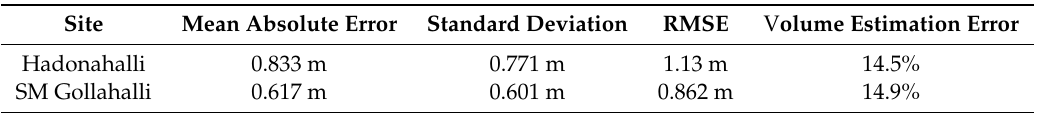
Table 3. Summary statistics for the elevation error measurements and the volume estimation error for Hadonahalli and SM Gollahalli